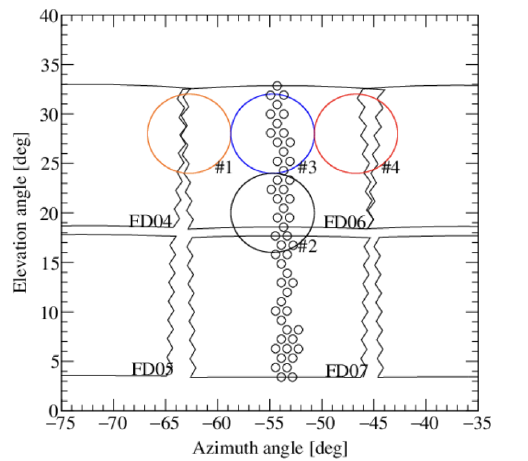
Figure 6. Event display of the air shower event same as Fig. 5 observed by TA FD. Field of view of CRAFFT is superposed. The circle color of CRAFFT field of view correspond to the waveform in Fig.